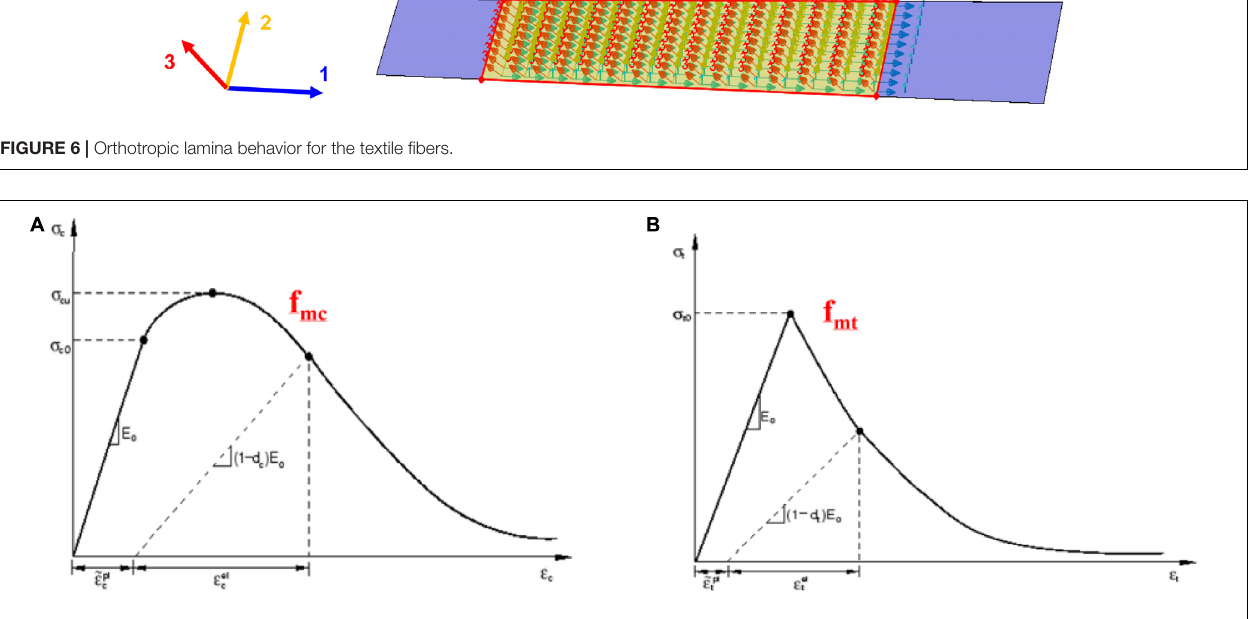
FIGURE 7 | Constitutive model of mortar: (A) in compression; (B) in tension.